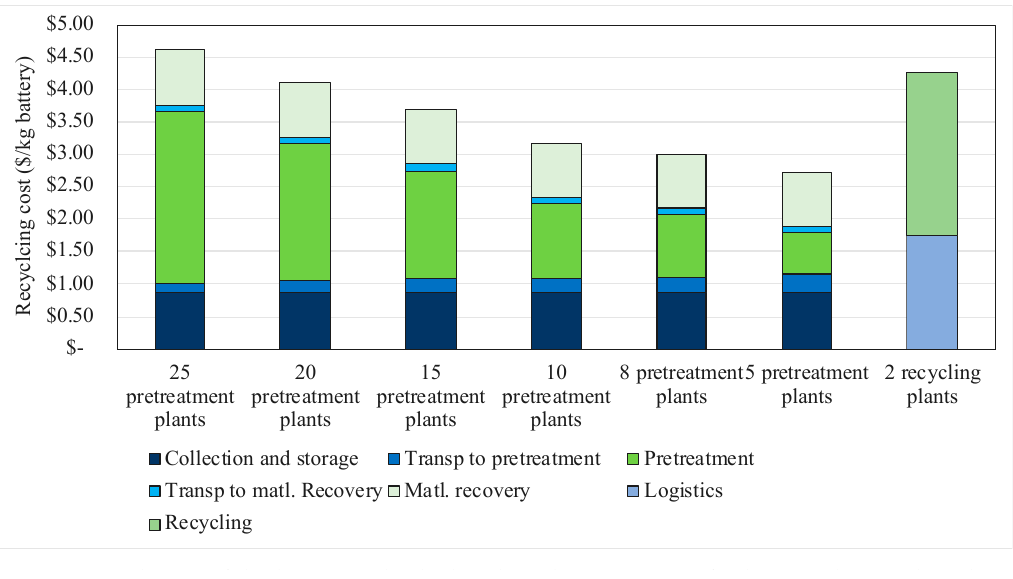
Figure 9. Total costs of deploying multiple distributed pretreatment facilities with a combined capacity of 50,000 tons/year, plus two hydrometallurgical facilities with a combined capacity of 30,000 tons/year, compared to that for two hydrometallurgical facilities with a combined capacity of 50,000 tons/year without pretreatment.